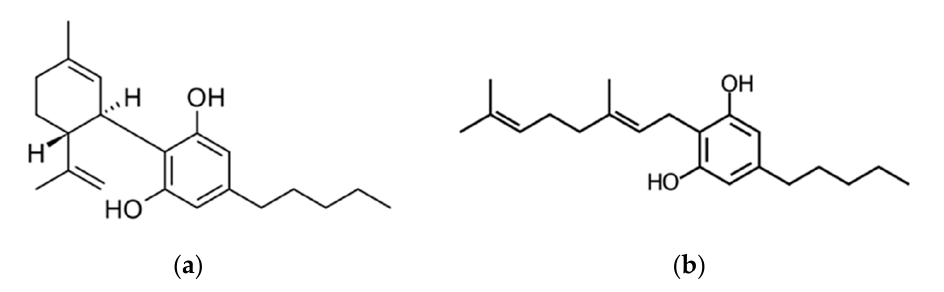
Figure 1. Chemical structures of ( a ) cannabidiol and ( b ) cannabigerol.